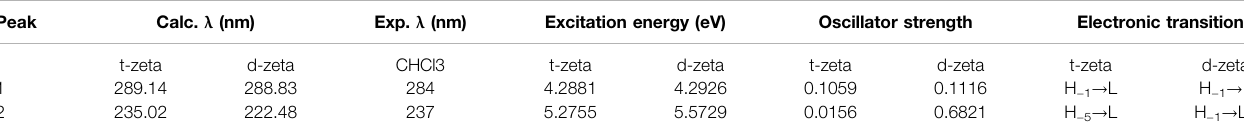
TABLE 3 | Experimental and calculated electronic excitations of epi-CD . Peak